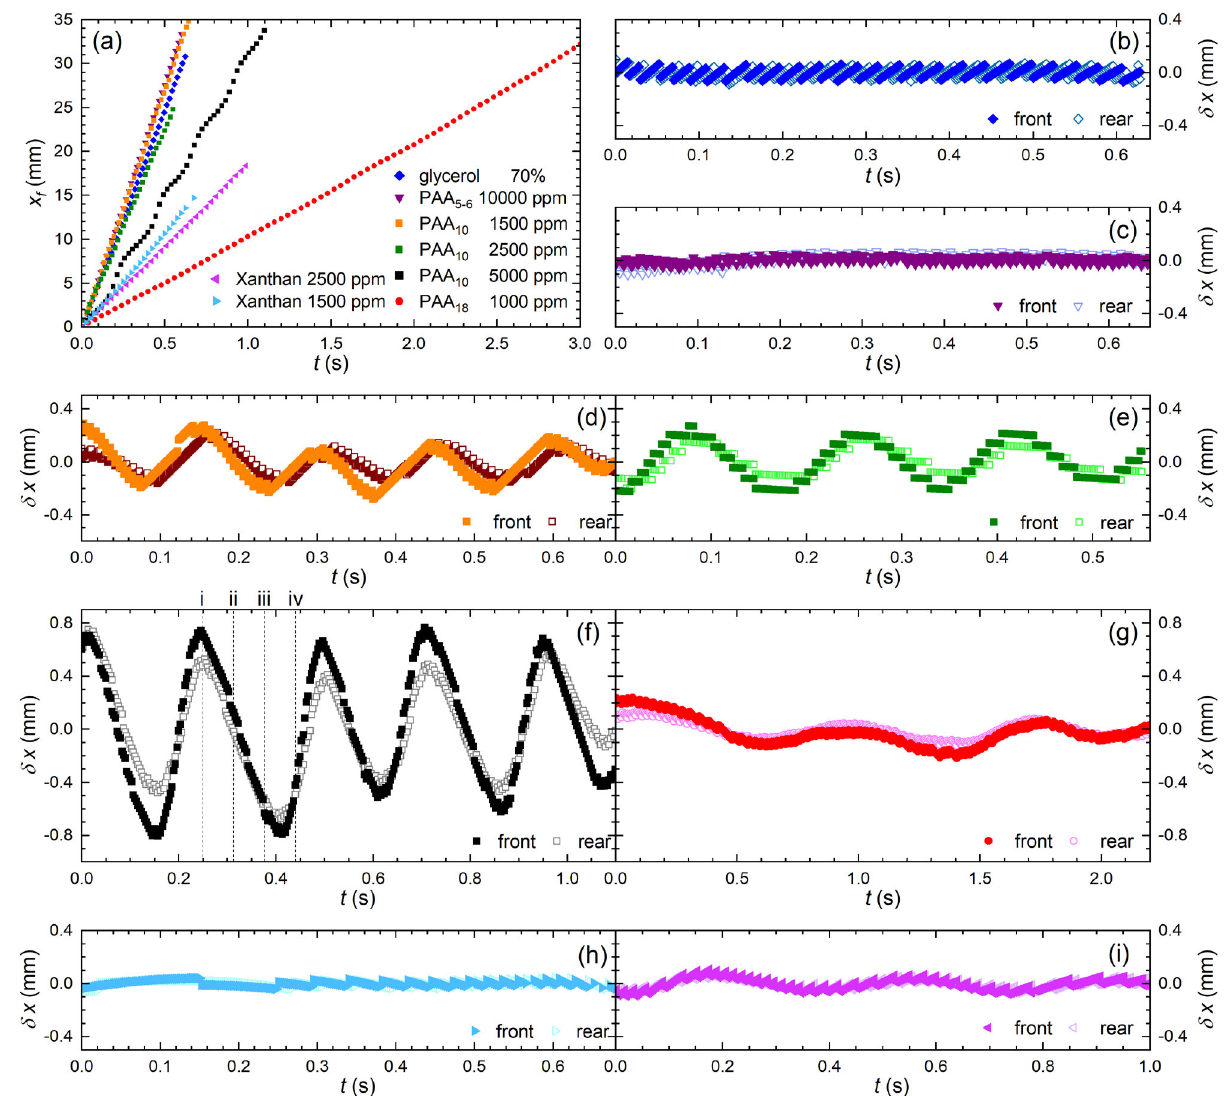
Fig. 3 Time evolution of descending drops. a Time evolution of the front position of the contact line x f of drops of different solutions having volume Ω = 30 μ L deposited on lubricated surfaces inclined by α = 30° ( α = 15° for the polyacrylamide PAA instantaneous deviation δ x of the front and rear contact points of drops of different solutions from the average linear trends reported in ( a ). Solid (open) symbols refer to the front (rear) contact point. The vertical dashed lines in panel ( f ), labelled from (i) to (iv), highlight the time instants corresponding to the snapshots in Fig.